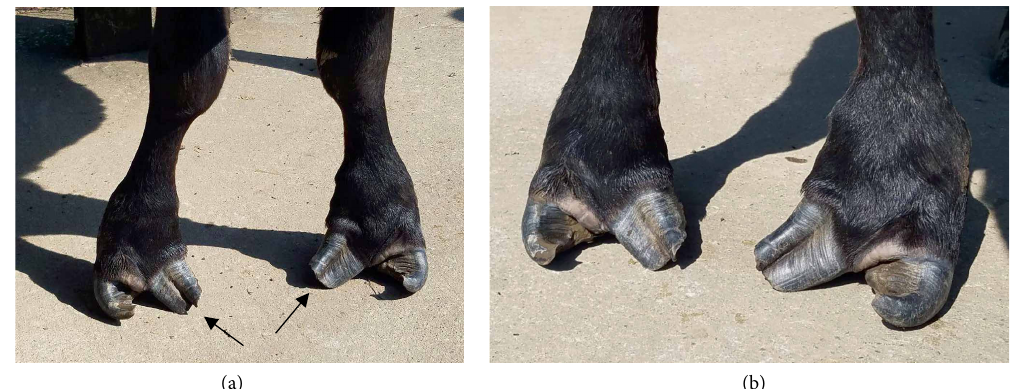
Figure 2: Dorsal view of the front feet of Dexter heifer Case 2 at 14 mo of age. (a) Lower limb view showing distorted leg structure. (b) Close- up of feet showing bilateral polydactyly based a third digit fused to the abaxial wall of each medial digit. Arrows indicate the notches or ridges on the hoof wall demarcating fused digits. All dew claws on these feet were